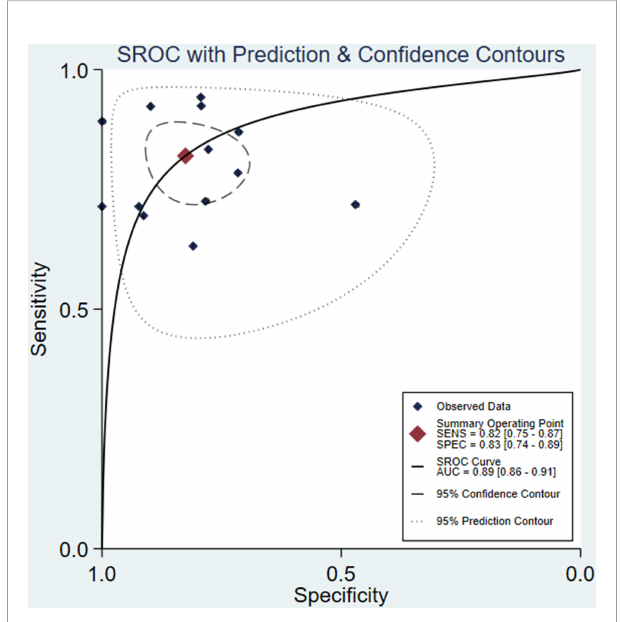
FIGURE 3 | Hierarchical summary receiver operating characteristic (SROC). curve of the diagnostic performance of ML-based radiomics of DCE-MRI in predicting ALNM in breast cancer.